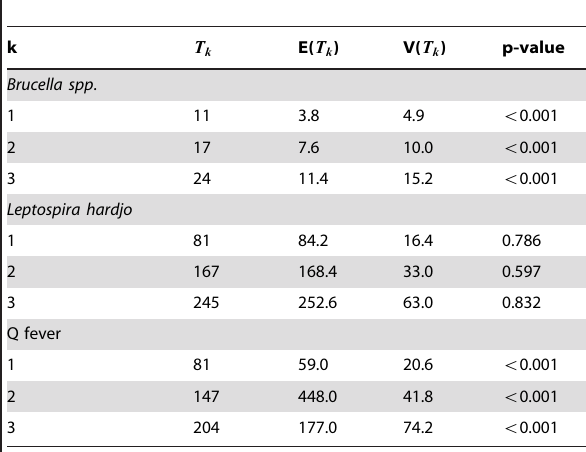
Table 4. Cuzick Edwards k th nearest neighbour analysis results for brucellosis, leptospirosis and Q fever in 146 randomly sampled herds from the Adamawa Region